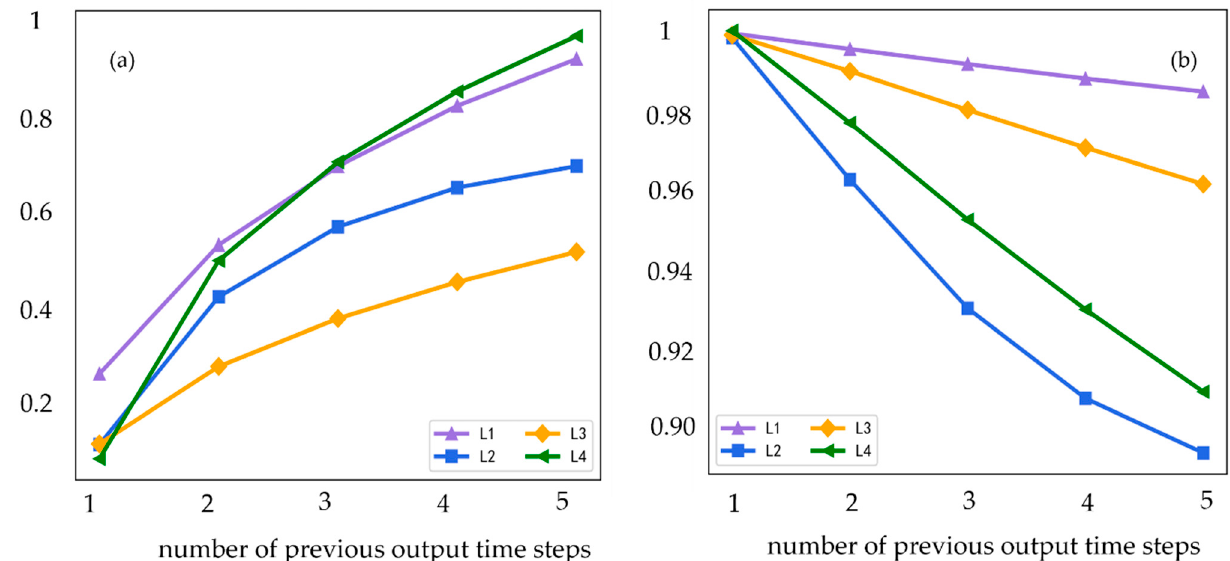
Figure 4. RMSE ( ◦ C) and R 2 of different prediction lengths at different positions, where lines with different colors represent different positions, ( a ) RMSE at different positions, ( b ) R 2 at different positions, the abscissa is the number of days predicted in advance.